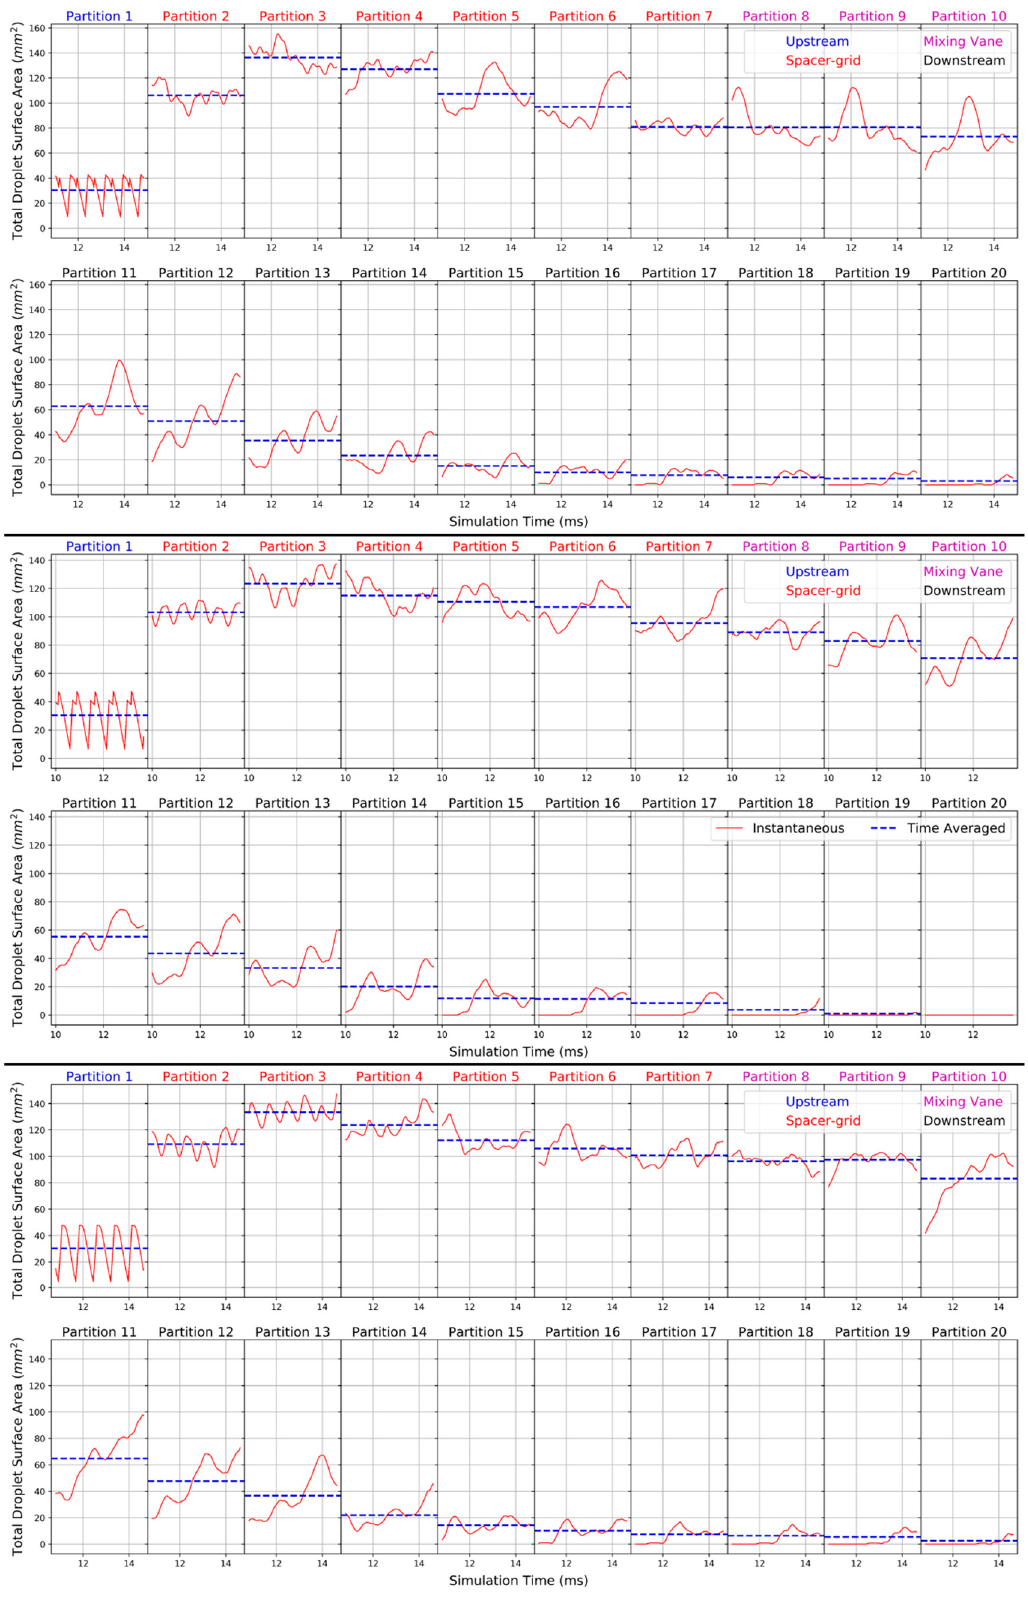
Figure 17. Axial evolution of total surface area in partitions for We40, We55 and We80 ( top – bottom ) water–steam system cases.